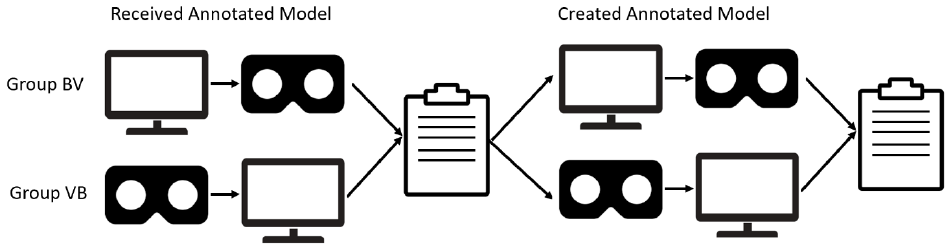
Figure 4. Experiment A—Asynchronous Collaboration’s procedure.